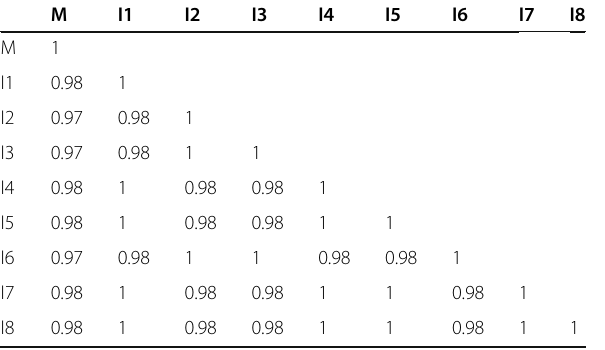
Table 4 Jaccard ’ s similarity coefficient for mother and in vitro regenerated plants of Anarrhinum pubescens based on RAPD markers